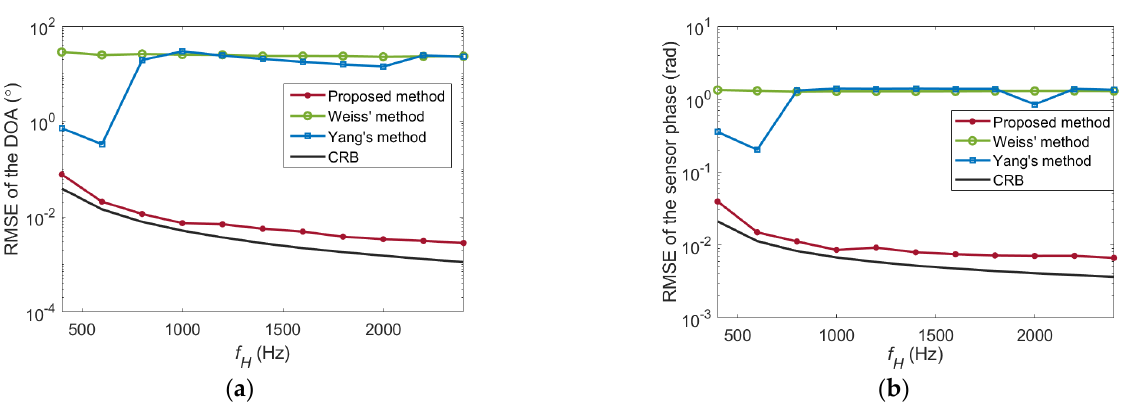
Figure 6. RMSEs versus the signal bandwidth: ( a ) DOA estimation; ( b ) DD sensor phase estimation.